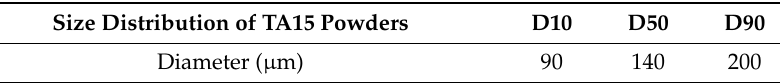
Table 3. Size distribution of TiB 2 powders (length).